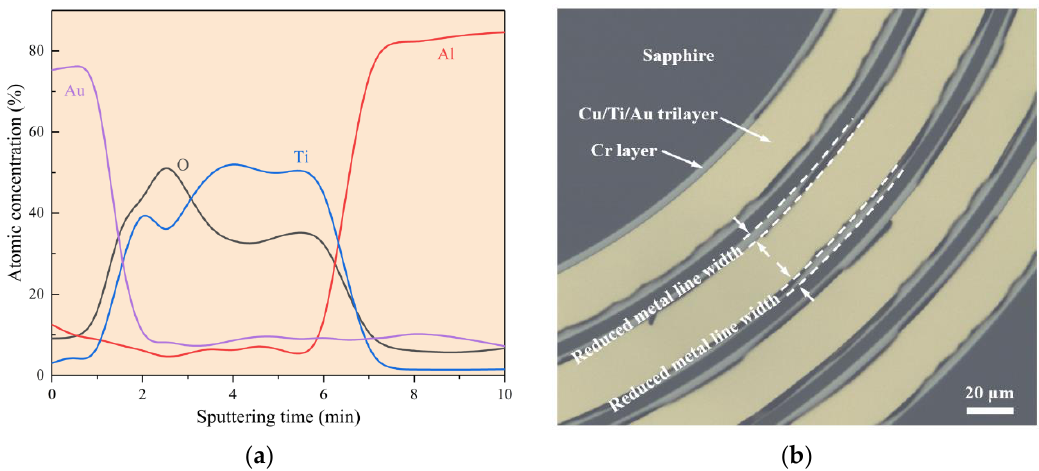
Figure 4. ( a ) Segmental in-depth profile of Cr/Al/Ti/Au-2 sample; ( b ) Uncovering sidewalls of Cu layer are oxidized and flake off in Cr/Cu/Ti/Au inductor.